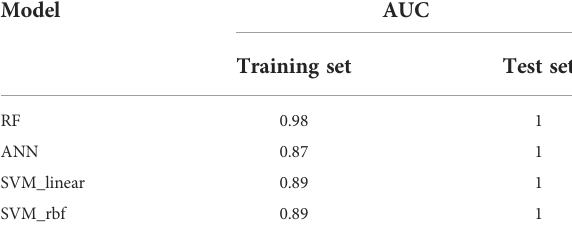
TABLE 5 The area under the curve of machine learning